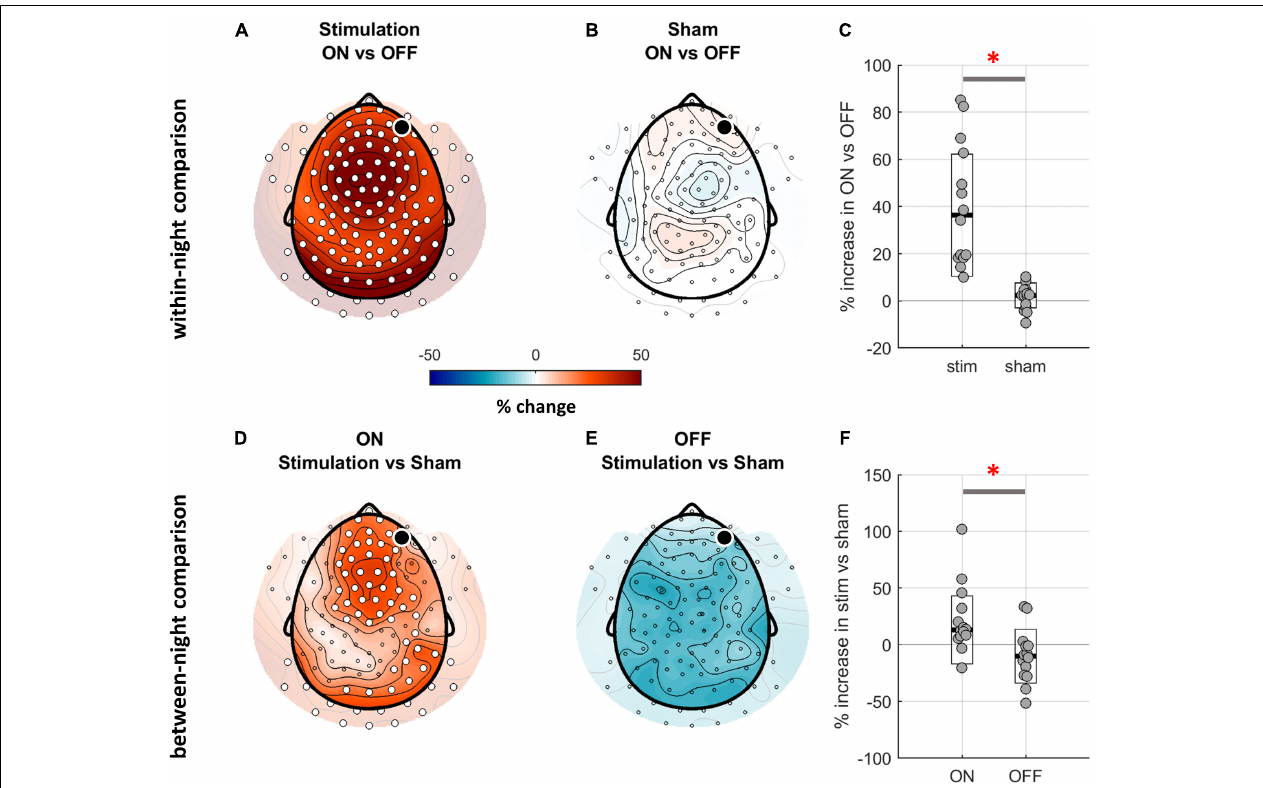
FIGURE 2 | Comparison of SWA (1–4 Hz) between ON and OFF windows of stim and sham nights. (A,B) Topographical distribution of SWA for the within-night comparison of ON and OFF windows. The black dot indicates the target channel Fp2, white dots indicate a significant change. While the ON-OFF-window contrast for the stim night reveals a global SWA increase in ON windows (cluster corrected paired two-sided t -test, N = 14, p clust < 0.001, d = 1.18), the same contrast for the sham night does not show any differences. (C) The relative SWA change between ON and OFF windows across all electrodes was significantly larger for the stim night as compared to sham night (average across all channels, t 13 = 5.07, p < 0.001; black line indicates median, white box with black outline indicates CI, red asterisk indicates significance). (D,E) Topographical distribution of SWA for the between-night comparison of ON and OFF windows. The contrast of ON windows between stim and sham nights confirms a stimulation-related boost of SWA ( N = 14, p clust = 0.01, d = 0.81). (F) The average increase in SWA when contrasting stim and sham night was significantly higher for the ON windows as compared to OFF (average across all channels, t 13 = 4.55, p =